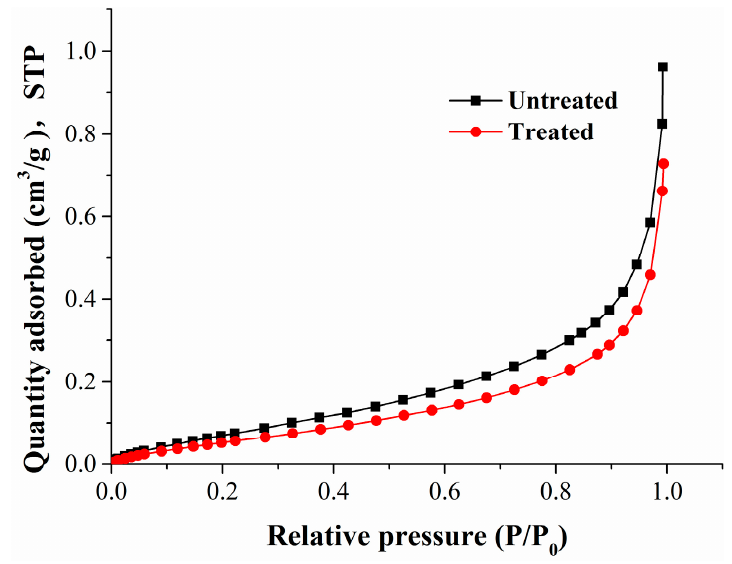
Figure 3. The adsorption isotherms for argon at 87 K.